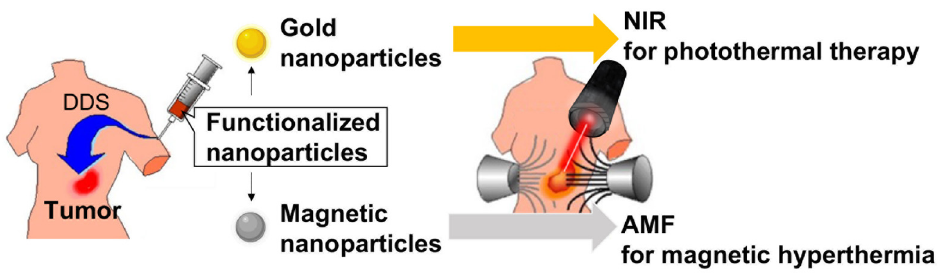
Figure 3. Hyperthermia using nanoparticles. DDS: drug-delivery system, NIR: near-infrared laser, AMF: alternating magnetic field.